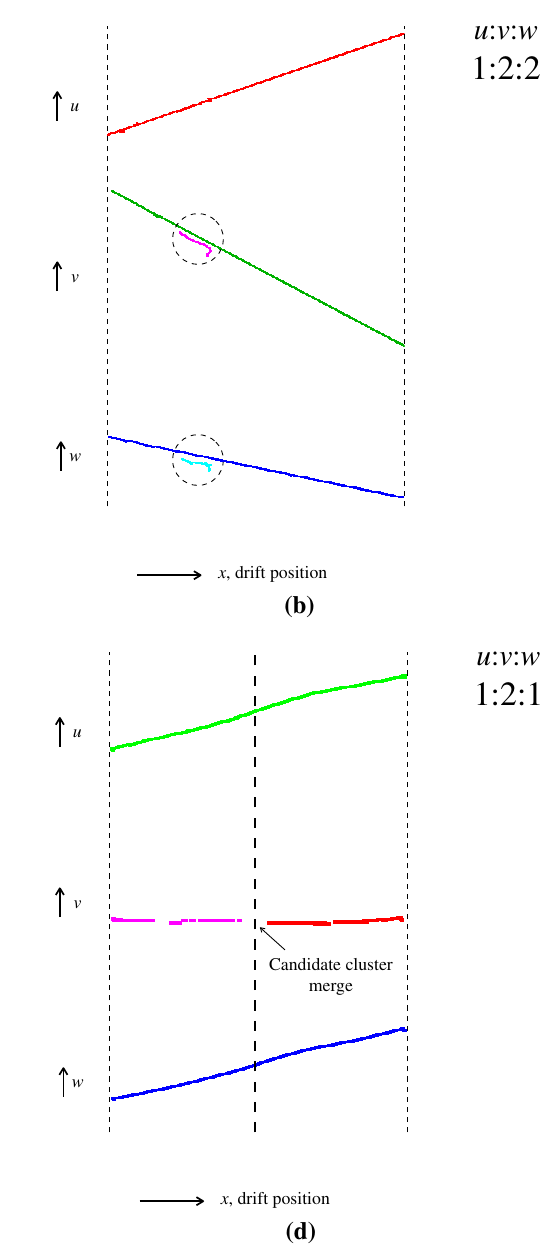
terscanbeidentified. c Anovershootintheclusteringinthe u viewleads to ambiguous cluster matching, which can be resolved by splitting the u cluster at the indicated position. d An undershoot in the clustering in the v view leads to ambiguous cluster matching, which can be resolved by merging the two v cluster